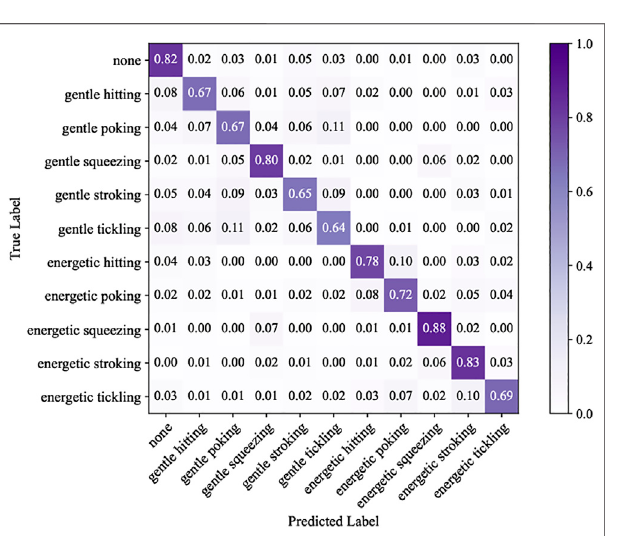
Frontiers in Robotics and AI |